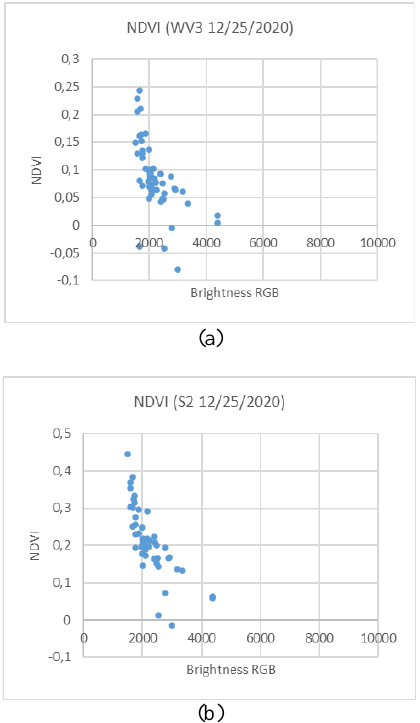
Figure 13 . Scatterplots relating NDVI and brightness values calculated on WV3 (a) and S2 (b) imagery for each PCG in